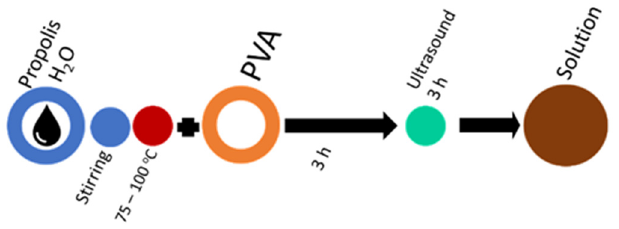
Figure 5. The mixing sequence required for PVA electrospinning solutions.